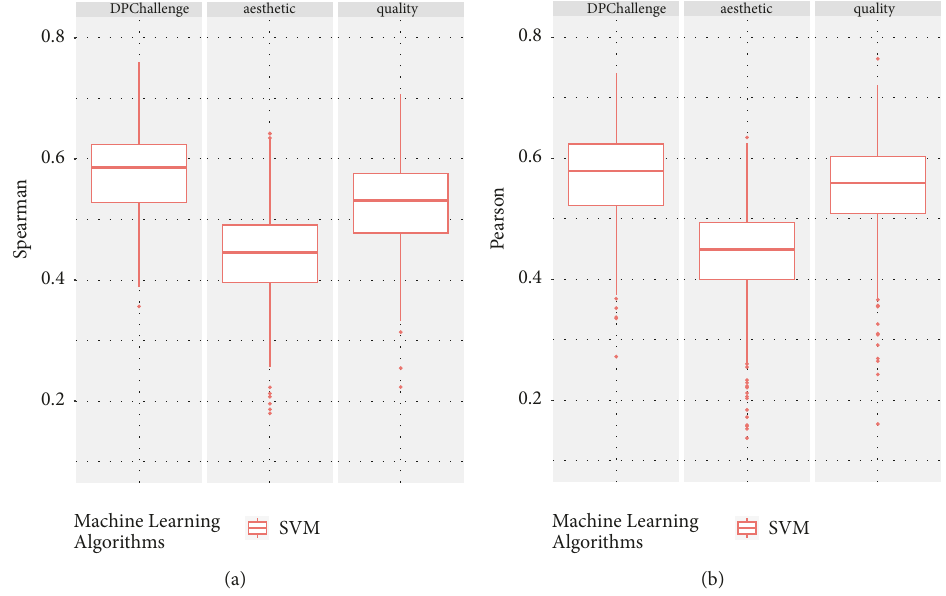
Figure 7: Distribution of correlations (Spearman’s on the right and Pearson’s on the left) obtained for each of the three criteria (DPChallenge, Aesthetic, and Quality) using 256 input variables and an SVM model optimised using hyperparameterisation.